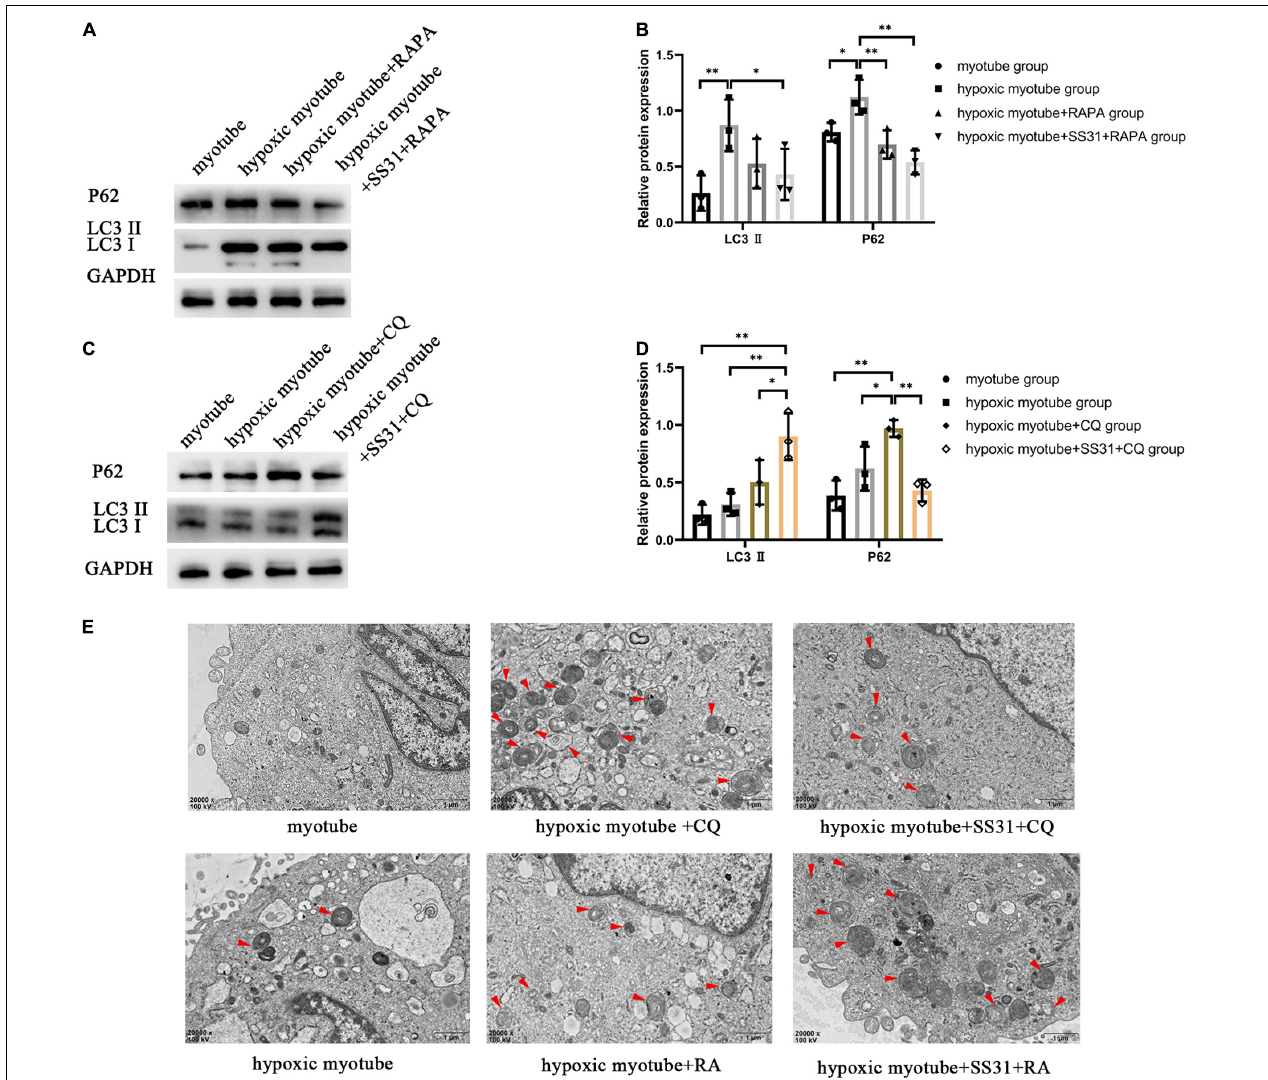
FIGURE 4 | SS31 activates autophagic flux in C2C12 myotubes. (A,B) RAPA was the intervention for hypoxic myotubes treated with or without SS31. The expression of autophagy-related proteins LC3 II and P62 were examined. (C,D) CQ was the intervention for hypoxic myotubes with or without SS31 treatment, and in the lysates, LC3 II and P62 expression was detected by immunoblotting. (E) Autophagy vacuoles were observed via electron microscopy (EM) (magnification of × 20,000). Red arrowheads represent autophagosomes. The data were standardized on the basis of the GAPDH level. n = 3. ∗ p < 0.05, ∗∗ p <